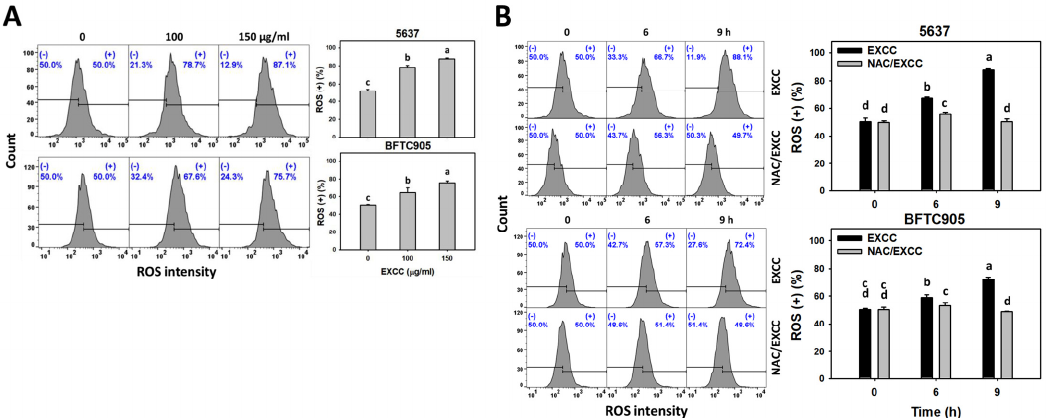
Figure 6. ROS change by EXCC. ( A ) ROS assay of EXCC. Two bladder cancer cell lines (5637 and BFTC905) were tested. Cells were treated with control (0.1% DMSO) and EXCC (100 and 150 μ g/mL) for 9 h. (+) represents ROS (+) population. ( B ) ROS assay of NAC/EXCC. NAC/EXCC is the NAC pretreatment (10 mM, 1 h) coupled with EXCC posttreatment (150 μ g/mL, 6 and 9 h). Statistical lower-case letters were given to each treatment. Non-overlapping letters between different treatments indicate significant results ( p < 0.05). Data, means ± SD ( n = 3). For example (5637 cells in Figure 6B), the EXCC (black color) 0, 6, and 9 h indicating “d, b, and a” show significant results between each other because these letters were non-overlapping. In contrast, EXCC 0 (black color) and NAC/EXCC (gray color) 0 h indicating “d” show nonsignificant results because these letters overlap.